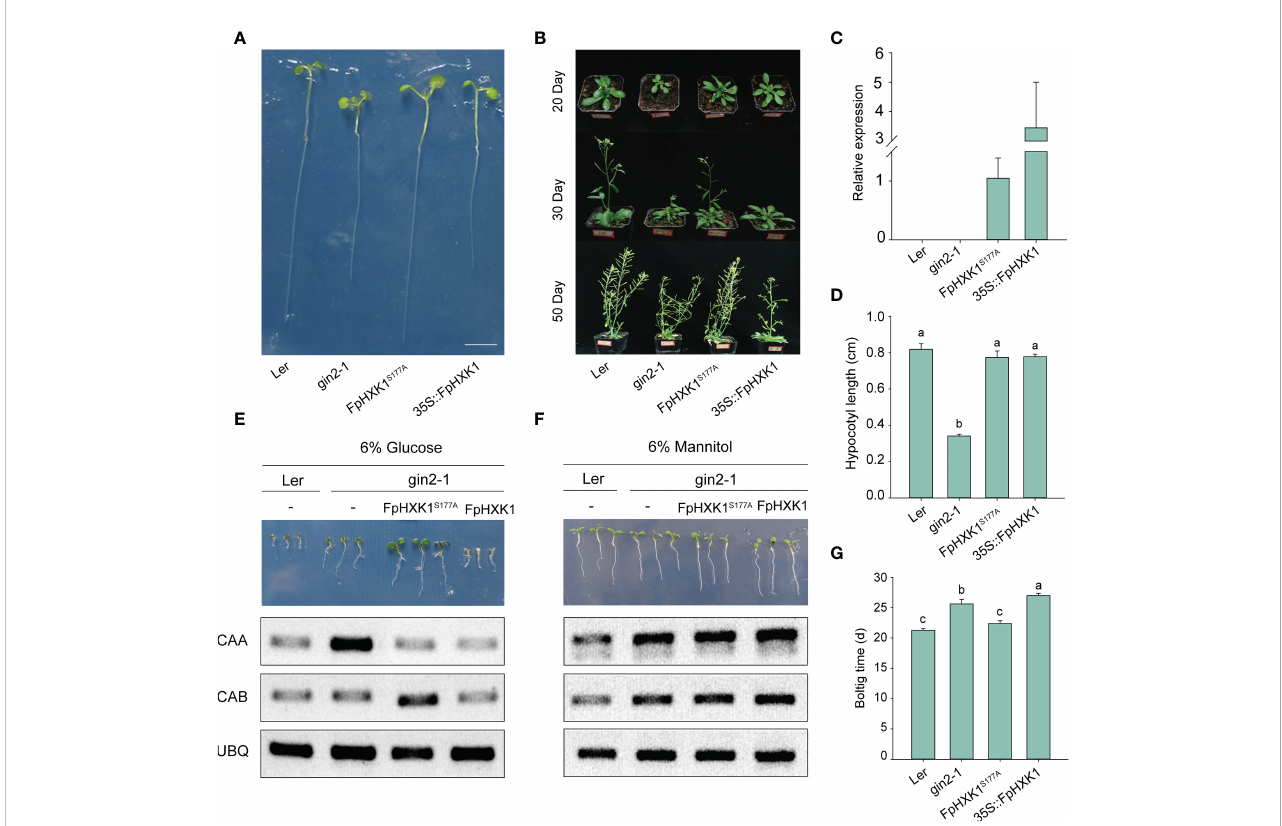
FIGURE 5 Complementation of ( A ) thaliana mutant gin2-1 with FpHXK1 or FpHXK1 S177A . (A) Seedling-growth analysis of Ler, gin2-1, 35S::FpHXK1 , and 35S:: FpHXK1 S177A under low-light and low-nutrient conditions (0.2% Glc, 1/10 MS) for eight days. Scale bar, 0.5 cm. (B) Plant phenotype of Ler, gin2-1 , and complementation of gin2-1 with 35S::FpHXK1 , and 35S::FpHXK1 S177A . (C) The relative gene expression level of FpHXK1 and FpHXK1 S177A in the gin2-1 background. TUB3 was used as an internal control. In the Ler wild-type and gin2-1 plants, no FpHXK1 or FpHXK1 S177A expression could be detected. (D) Hypocotyl length of seedings under low-light and low-nutrient. Values were presented as mean ± SEM of 6-10 seedings. Statistically signi fi cant differences among samples were tested by Tukey ’ s test, signi fi cantly different (p< 0.05) were indicated by different letters, as determined by a two-way analysis of variance. (E) Seedling-growth phenotype and the expression level of the CAA and CAB gene in Ler , gin2-1, 35S::FpHXK1 , and 35S::FpHXK1 S177A lines in 1/2 MS liquid medium with 6% glucose. Scale bar, 0.5 cm. (F) Seedling-growth phenotype and the expression level of the CAA and CAB gene in Ler , gin2-1, 35S::FpHXK1 , and 35S::FpHXK1 S177A lines in 1/2 MS liquid medium with 6% mannitol. Scale bar, 0.5 cm. (G) Bolting time of the gin2-1 , Ler wild-type and complementation